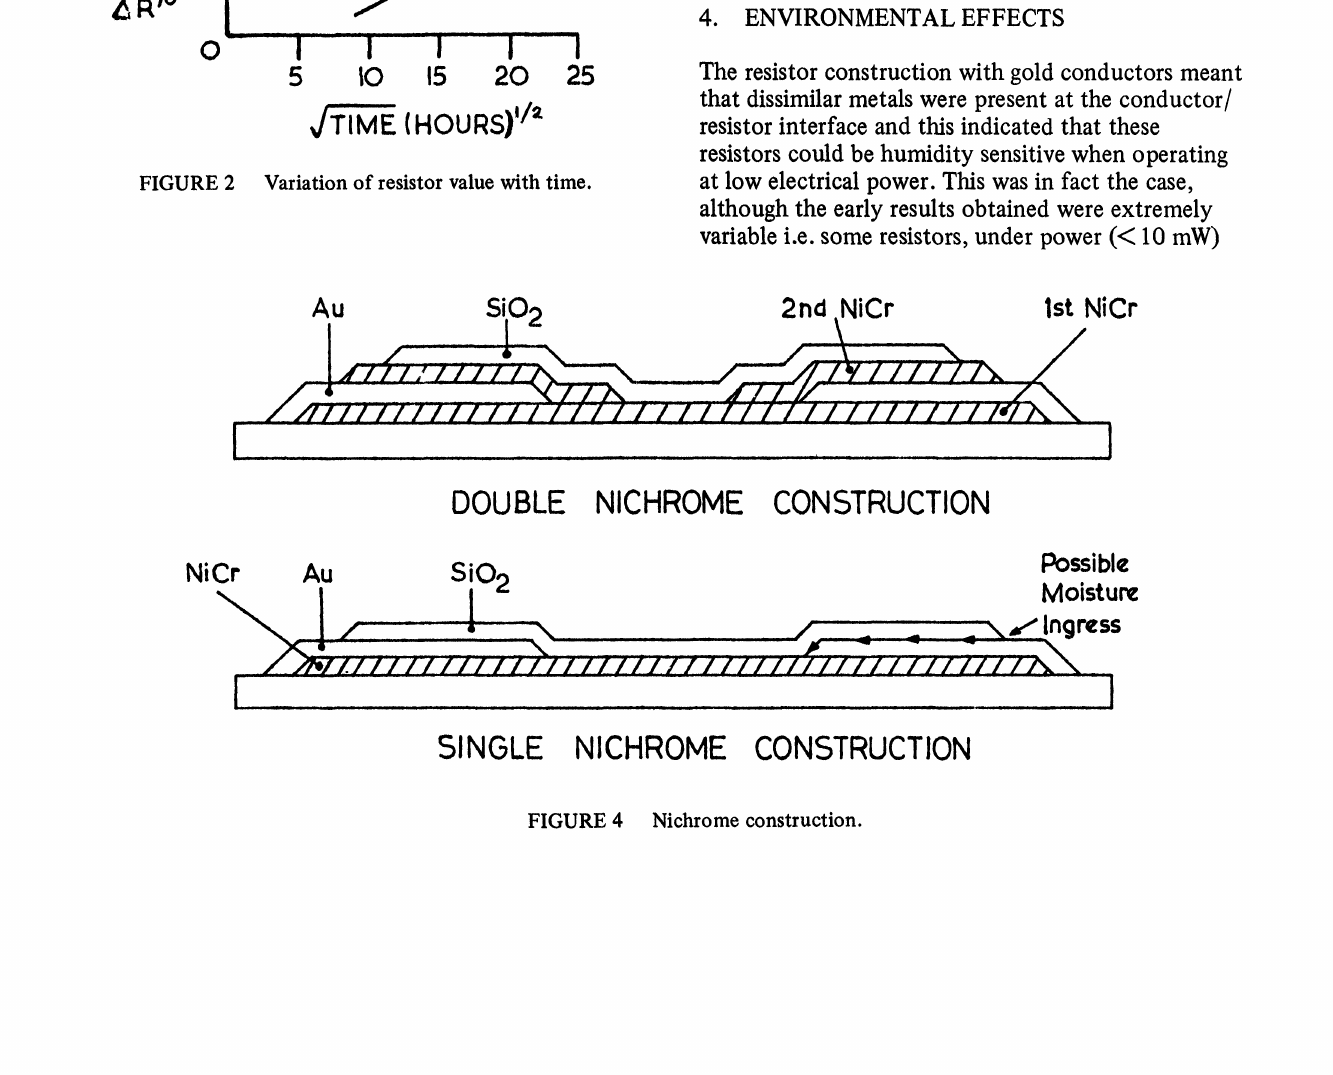
Variation of resistor value with temperature.